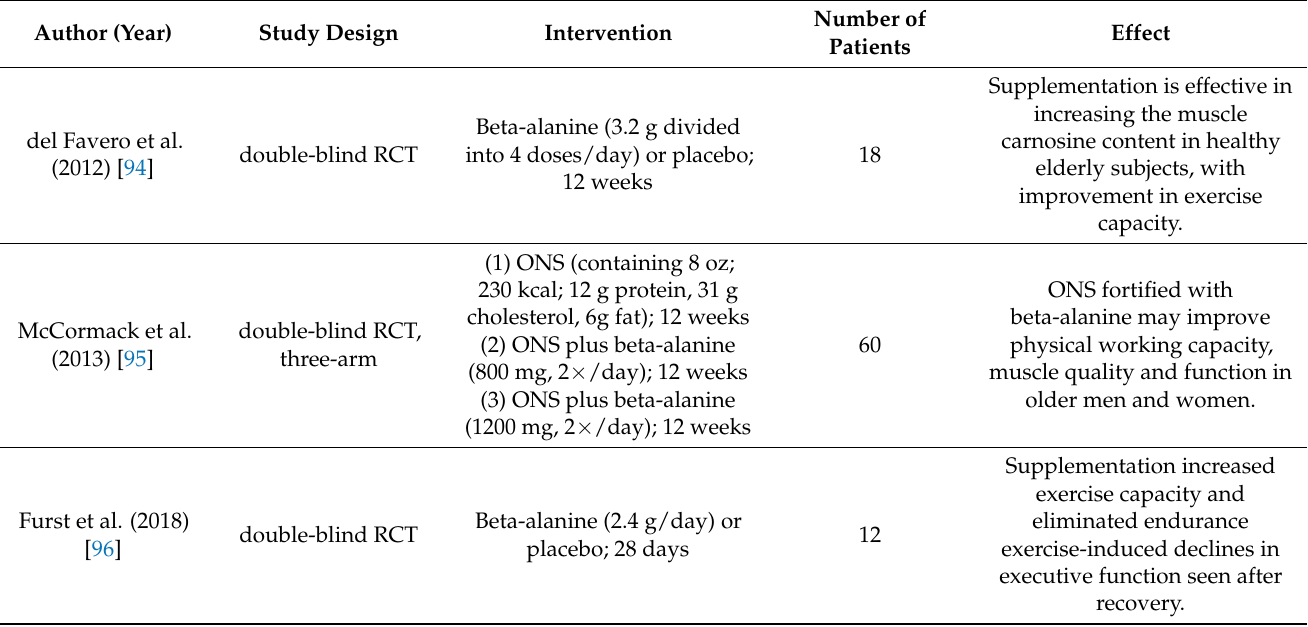
Table 4. Carnosine, beta-alanine and